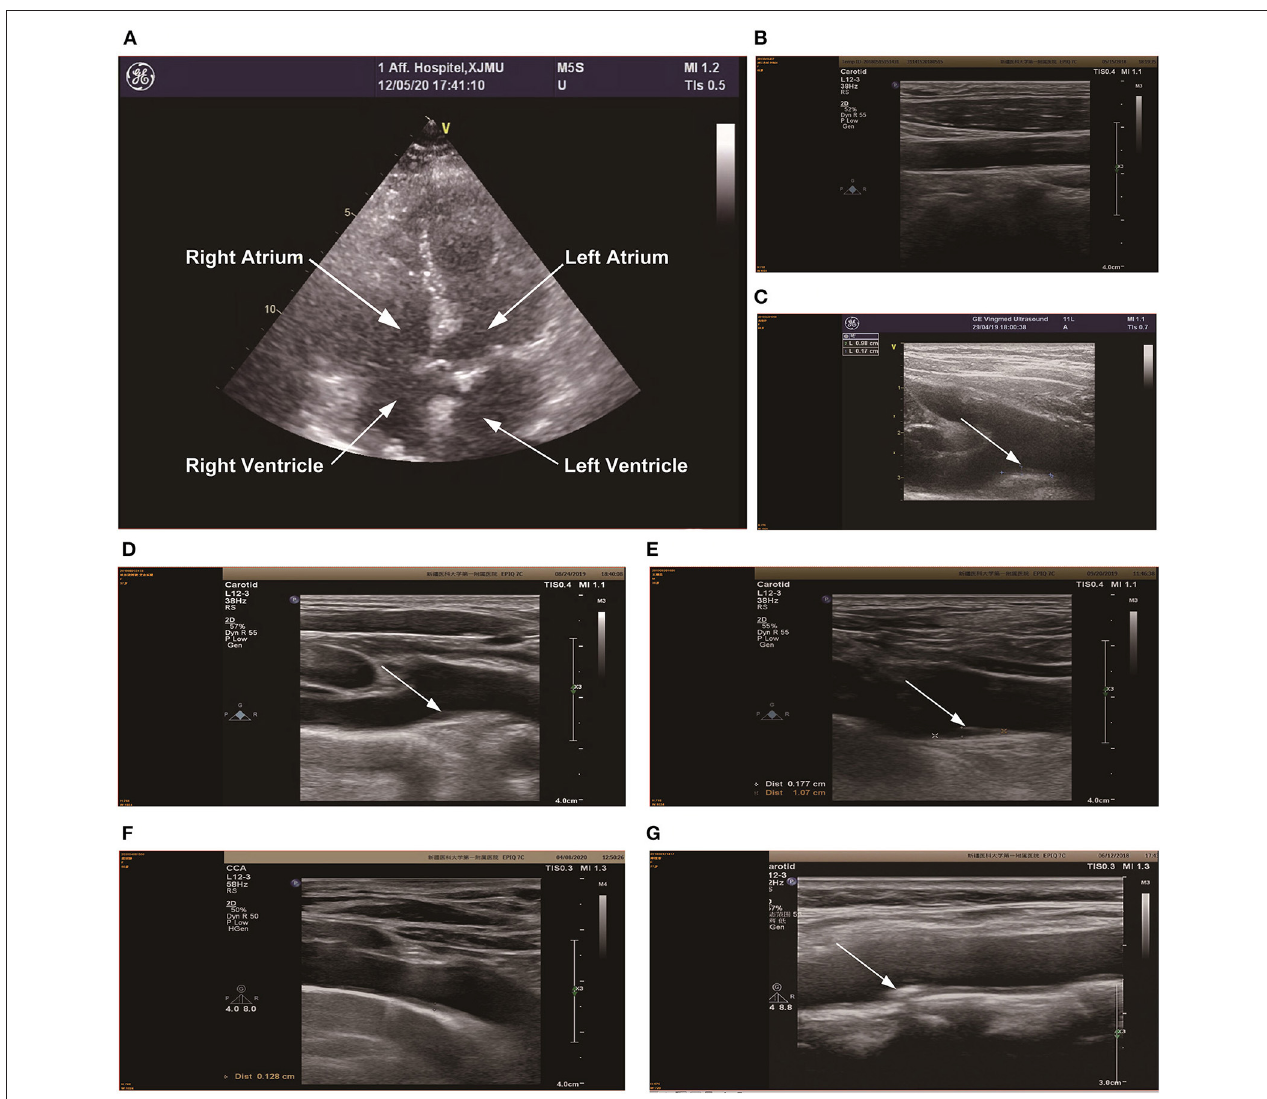
FIGURE 6 | Color Doppler ultrasonography of the neck and heart was performed in 6 patients. (A) The heart color Doppler ultrasound image of patient 9, and the results suggested left atrial enlargement, reduced left ventricular myocardial phase motion, mitral valve insufficiency, active surface insufficiency, and mild pulmonary hypertension. (B) is the cervical vascular color Doppler ultrasound of patient 3, there were no obvious abnormalities in cervical vascular ultrasound. (C) is the cervical vascular color Doppler ultrasound of patient 4, and the results suggested that the innameless artery bifurcation and the plaque size of the right subclavian artery was about 9.8 × 1.7mm, which has been marked in the figure. (D) is the cervical vascular color Doppler ultrasound of patient 5, and the results suggested that the innameless artery bifurcation and the plaque size of the right subclavian artery was about 10 × 1.8mm, which has been marked in the figure. (E) is the cervical vascular color Doppler ultrasound of patient 6, and the results suggested that the innameless artery bifurcation and the plaque size of the right subclavian artery was about 11.1 × 1.8mm, which has been marked in the figure. (F) is the cervical vascular color Doppler ultrasound of patient 8, intima thickening of the left carotid artery (1.2mm), bifurcation of the innominate artery and thickening of the right subclavian artery (1.3mm), which has been marked in the figure (G) is the cervical vascular color Doppler ultrasound of patient 9, there were no obvious abnormalities in cervical vascular